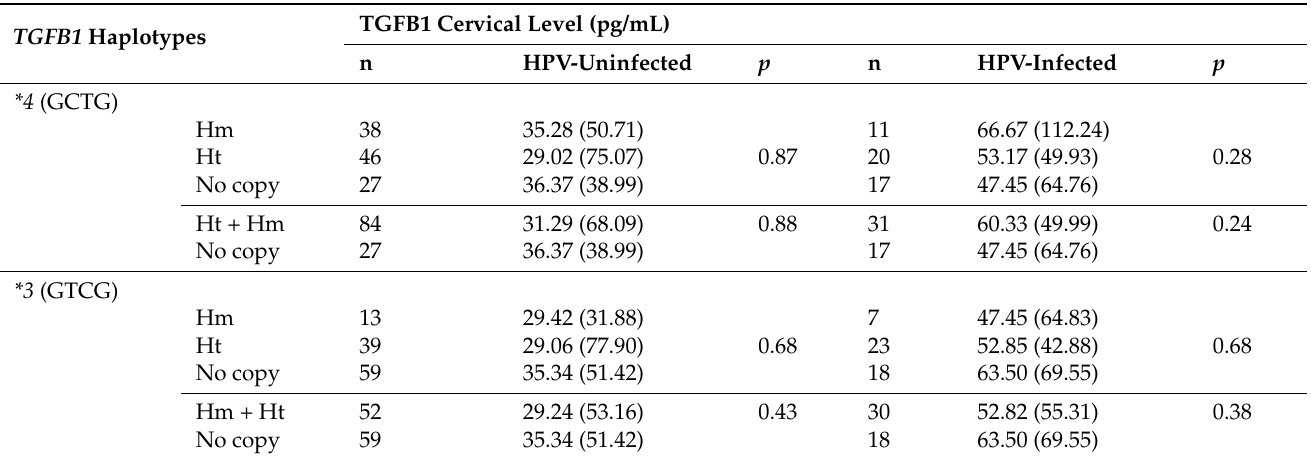
Table 6. Cervical levels of TGFB1 according to TGFB1 haplotype models in uninfected and infected